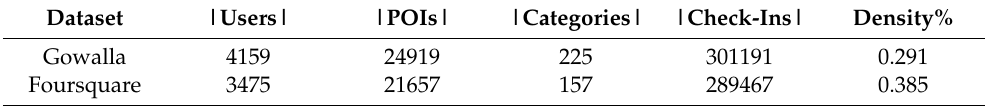
Table 2. Statistics of the